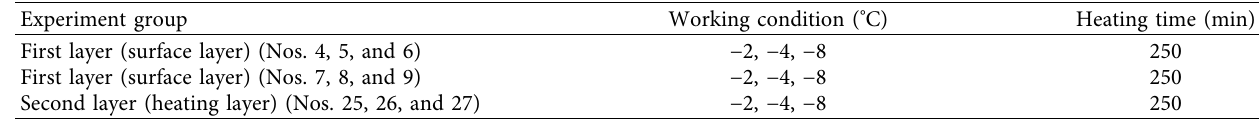
Figure 8: Icing and melting ice under the − 2 ° C working condition: (a) icing and (b) melting ice. Table 3: Ice melting experiment